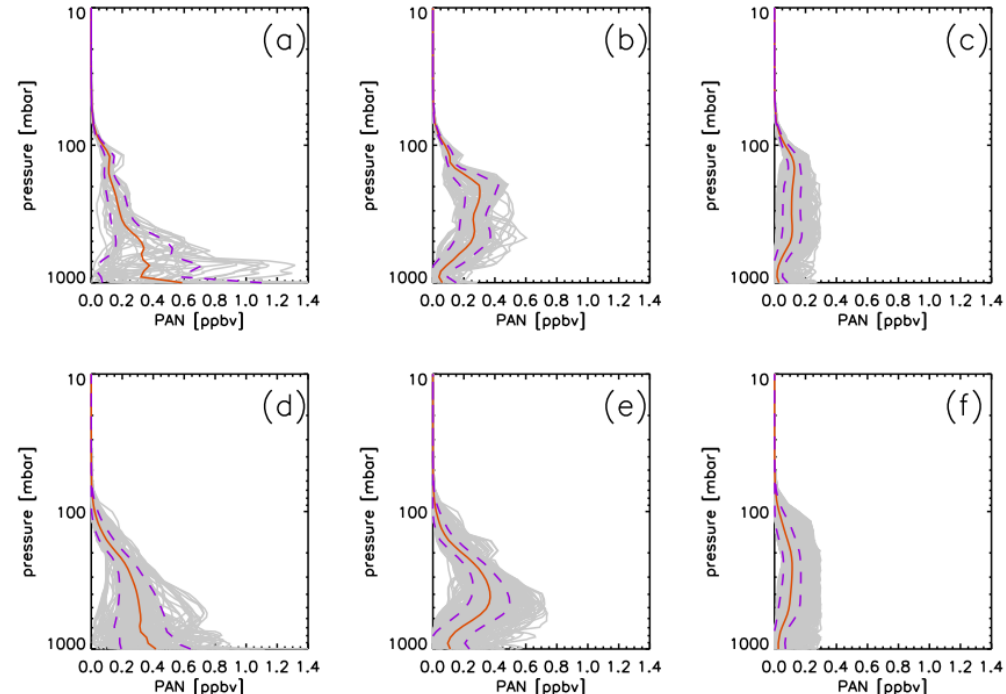
Figure 4. PAN profiles simulated by GEOS-Chem over the whole globe for July 2008, binned by type (in gray): (a) tropical profiles with a surface maximum; (b) tropical profiles with a maximum aloft; (c) tropical profiles with peak value < 0.3ppbv; (d) outside tropics, surface maximum; (e) outside tropics, maximum aloft; and (f) outside tropics, peak value < 0.3ppbv. The mean profiles for each category (shown in red) are used as a priori profiles in the TES PAN retrieval. Standard deviations about the mean (shown as purple dashed lines) are shown for information, but are not used in the construction of the retrieval constraints.